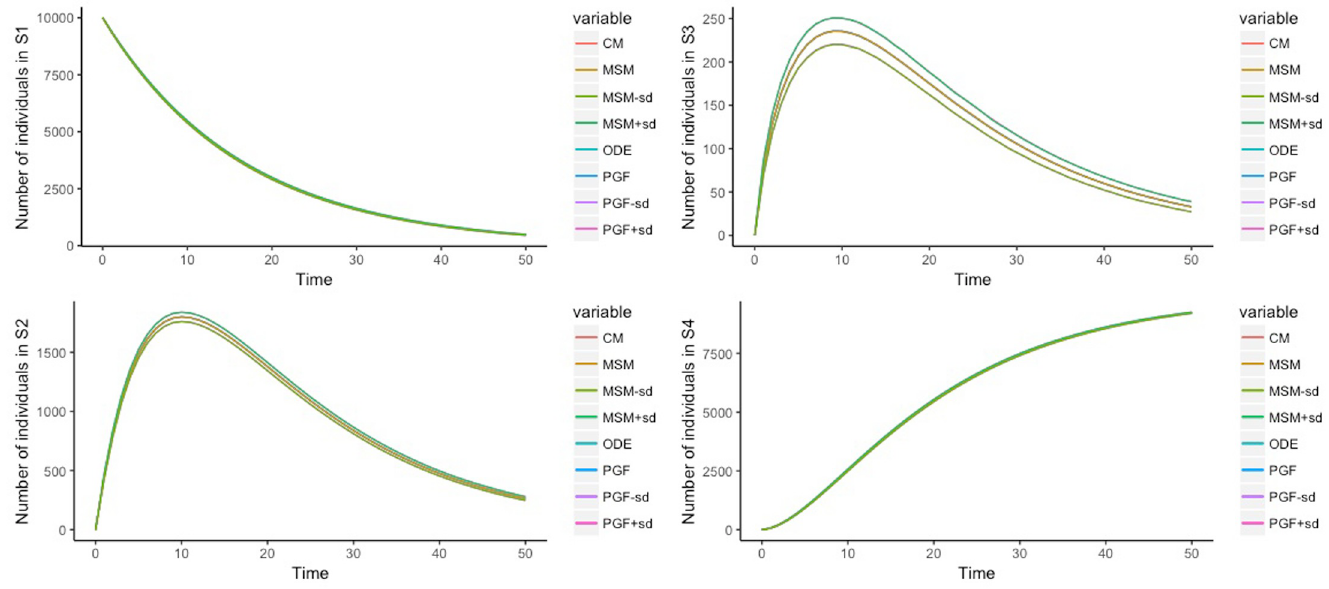
Fig 2. Population trajectories across 4 states. [CM: Cohort model, MSM: Microsimulation, ODE: Continuous-time cohort model, PGF: Master equation, sd: Standard deviation]. Note: plots are on top of each other.